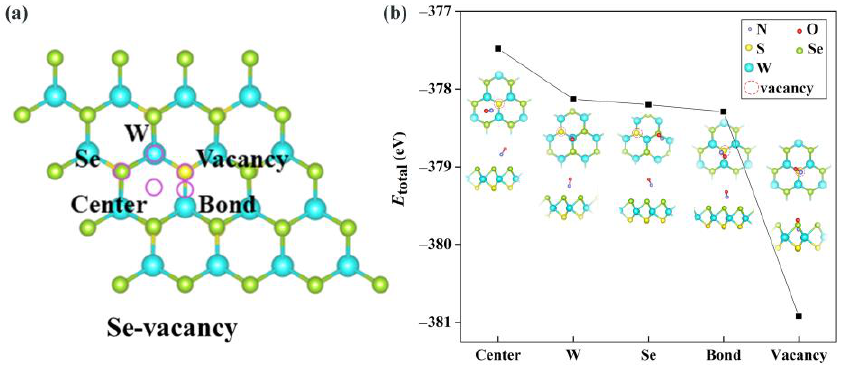
Figure 4. ( a ) Possible adsorption sites (symbolized in purple circles) considered for the case of de- fective WSSe. ( b ) The 𝐸 𝑡𝑜𝑡𝑎𝑙 of this NO adsorption system with various adsorption sites. defective WSSe. ( b ) The E total of this NO adsorption system with various adsorption